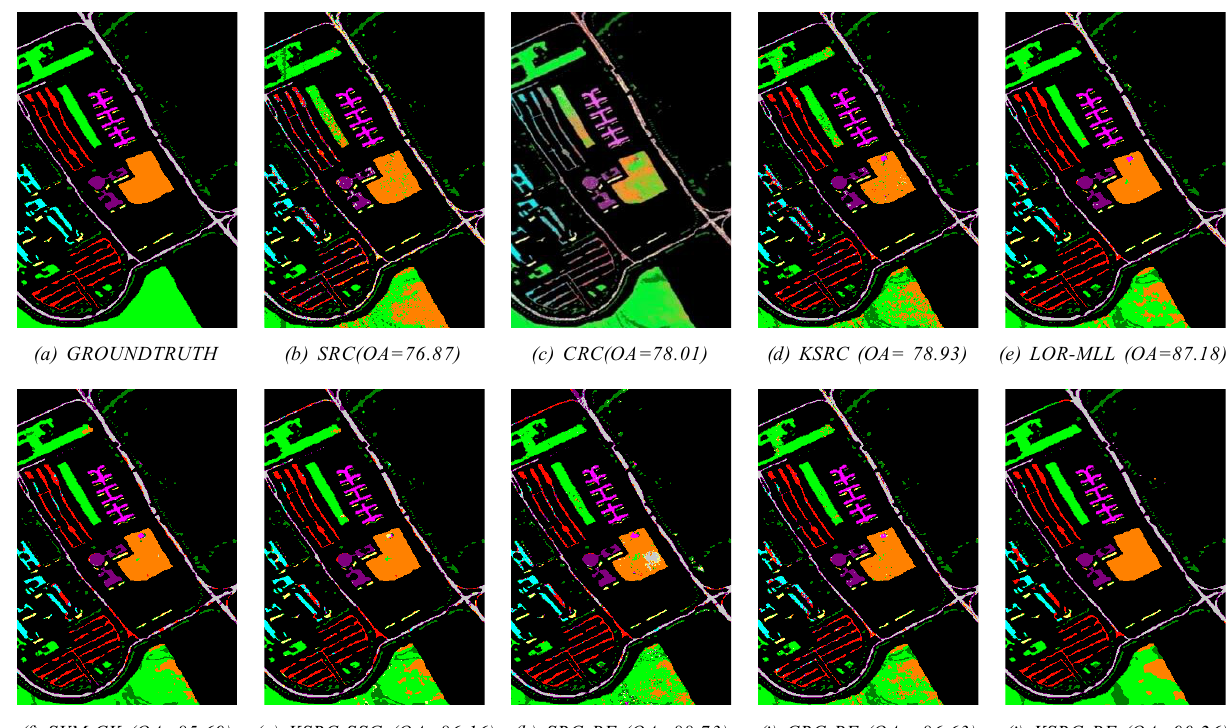
FIG. 3. UNIVERSITY OF PAVIA IMAGE: REFERENCE DATA AND VISUAL CLASSIFICATION